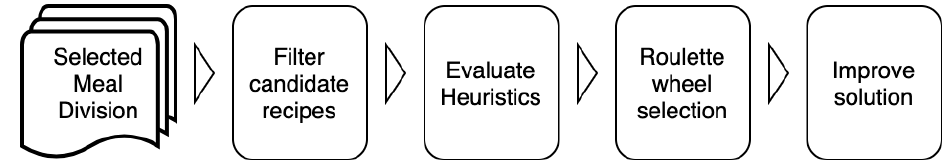
Figure 2. Overview of the SousChef planning algorithm.